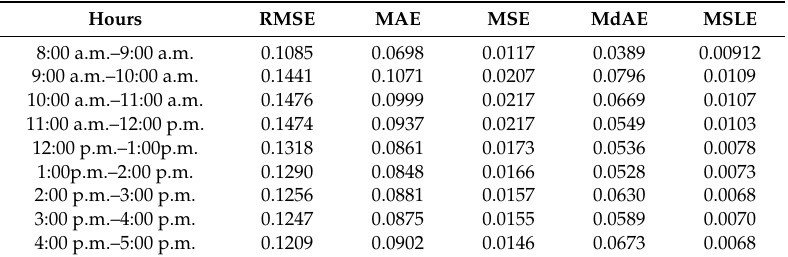
Table 5. Hour-Wise Results of deep LSTM.